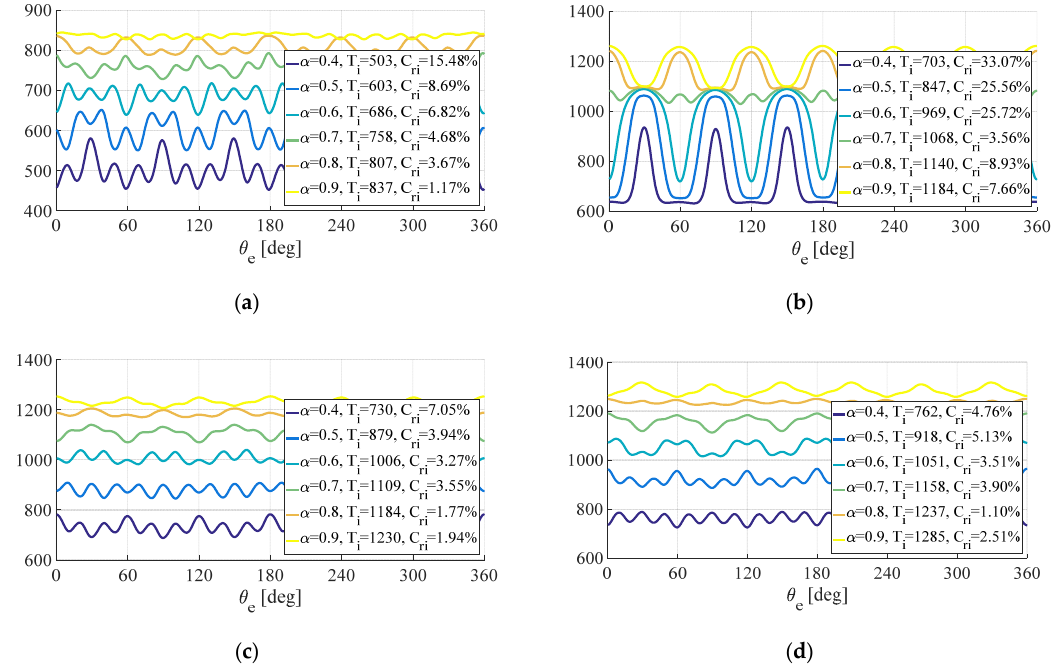
Figure 10. Ideal electromagnetic torque T i in Nm of 8 poles ( a ), 12 poles ( b ), 14 poles ( c ) and 16 poles ( d ) rotors.